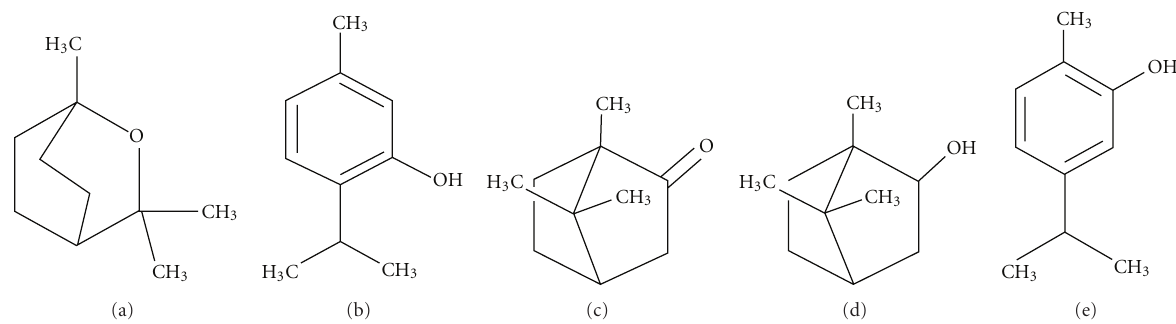
Figure 1: Chemical structures of the main compounds present in the supercritical extracts of the three thyme varieties: (a) 1,8 cineole, (b) thymol, (c) camphor, (d) borneol, and (e) carvacrol.